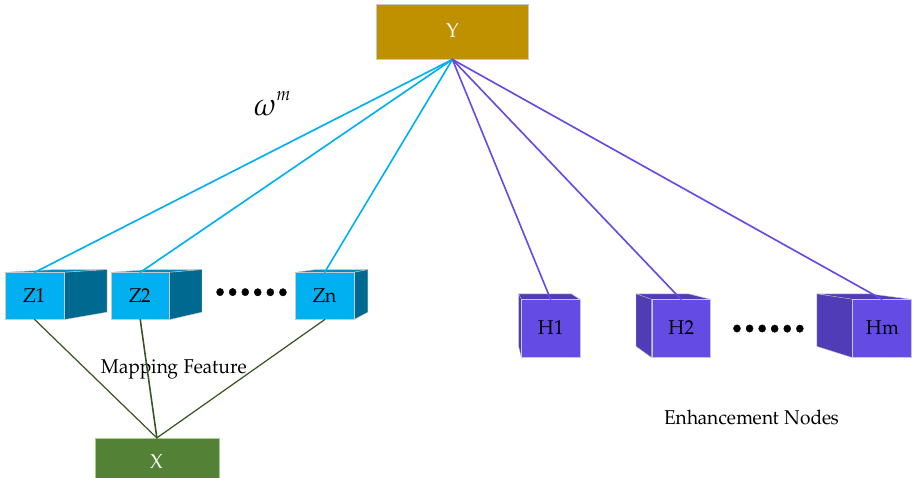
Figure 1. Network structure diagram of Broad Learning System.